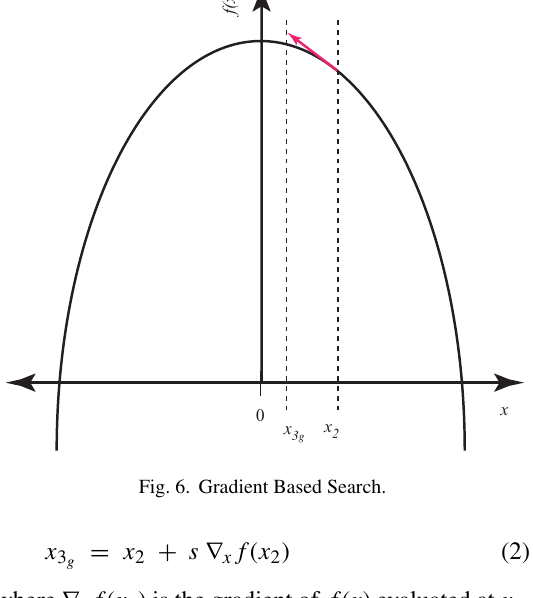
Fig. 6. Gradient Based Search.